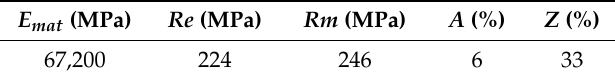
Table 5. Mechanical properties of the evaluated set